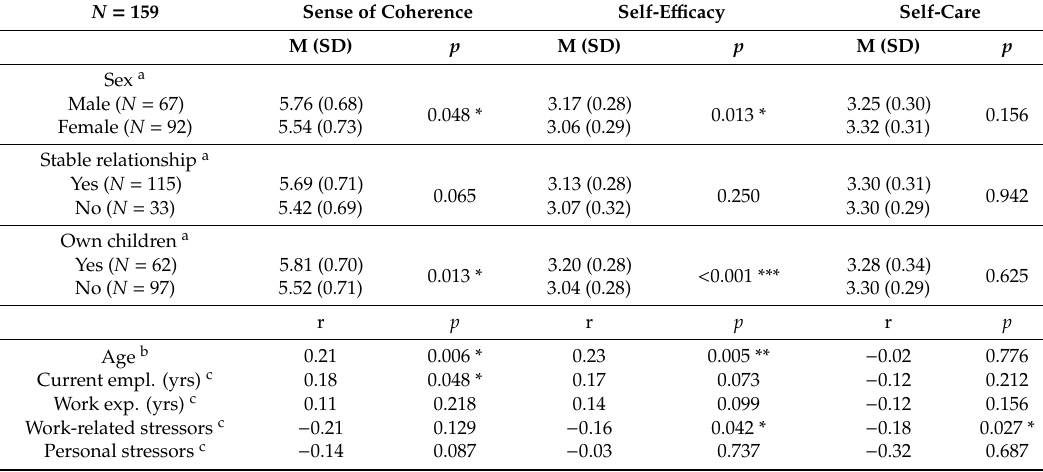
Table 1. Cross-sectional analysis of sociodemographic variables and resilience measures at study entry for the study population of professional caregivers.